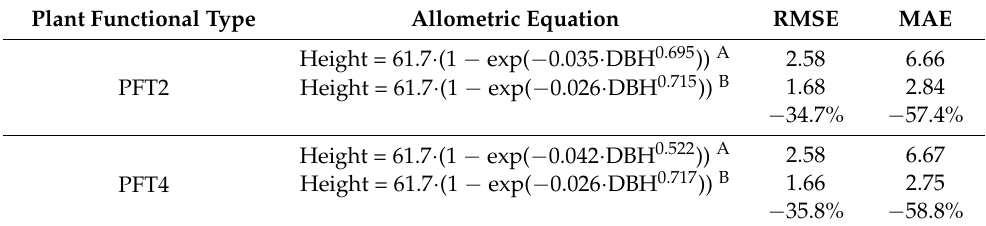
Table 3. Calibration of DBH-height allometric equation for PFT2 and PFT4. Plant Functional Type Allometric